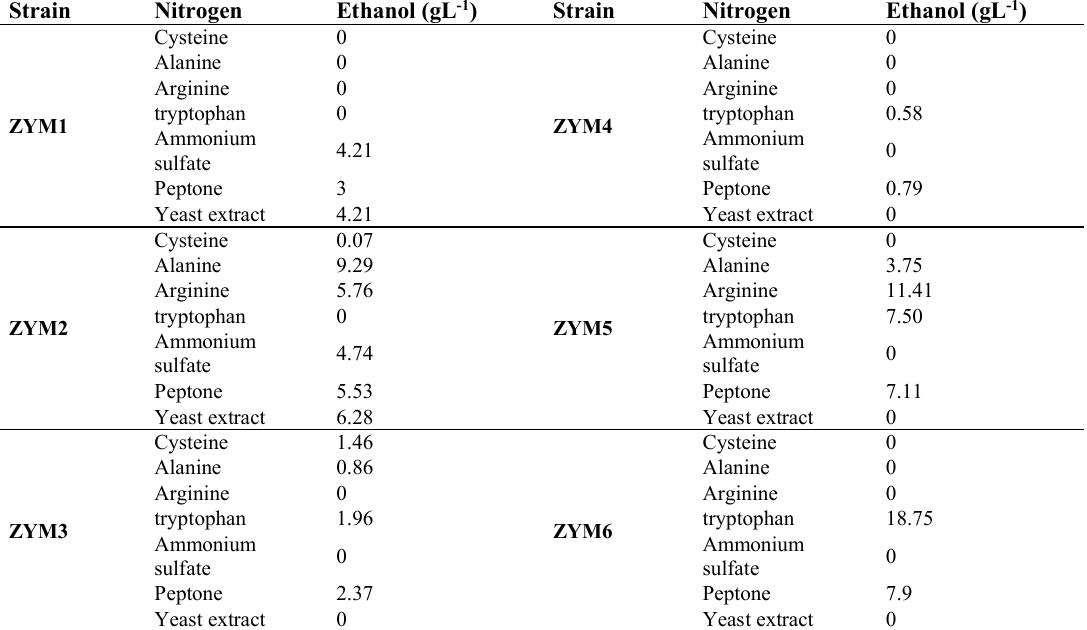
Table 4. Effect of nitrogen sources on ethanol production by